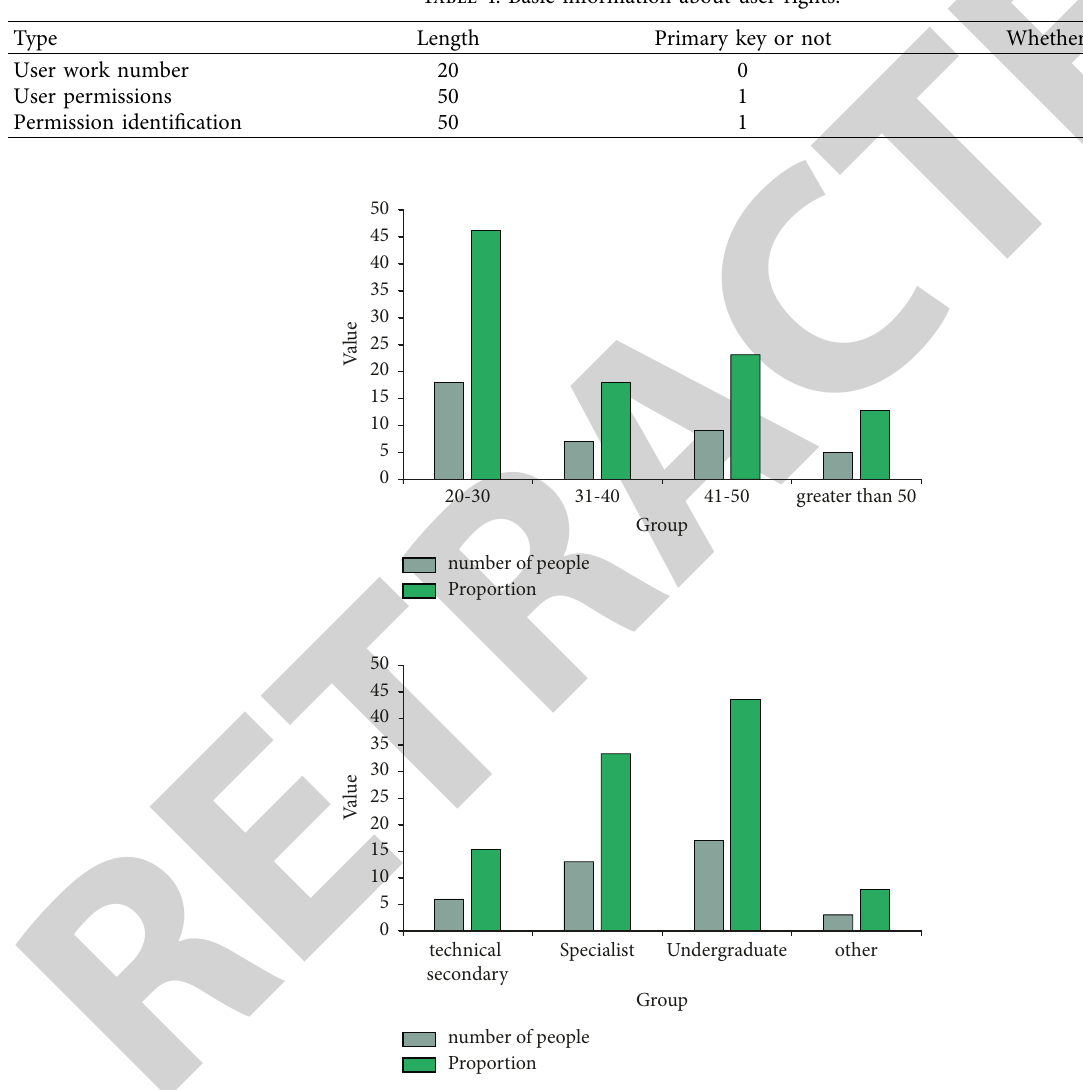
Figure 7: Age and education distribution of